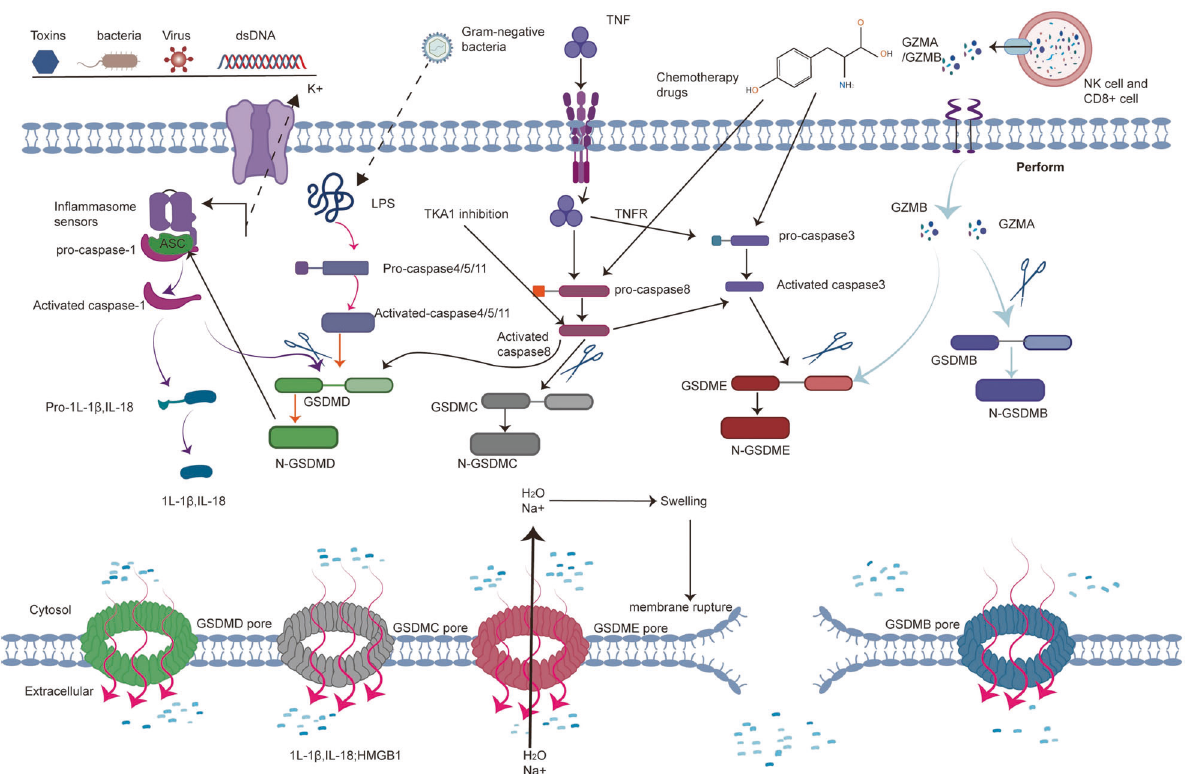
Fig. 1 Molecular mechanism of pyroptosis. The canonical in fl ammasome is assembled from intracellular sensor proteins in response to PAMPs and DAMPs. Active caspase-1 cleaves pro-IL-1 β and pro-IL-18 and results in the maturation of IL-1 β and IL-18 that are subsequently released from the N-GSDMD pore. Active caspase-1 also cleaves GSDMD, releasing N-GSDMD to form nonselective pores on the plasma membrane, which allows the release of mature IL-1 β and IL-18. In the noncanonical pathway, LPS directly binds to pro-caspase-4/5/11, resulting in activation of caspase-4/5/11, which cleaves GSDMD to trigger pyroptosis. In apoptotic caspase-induced pyroptosis, TNF activates caspase-8, which cleaves GSDMC and then induces pyroptosis in cancer cells. In addition, chemotherapeutic drugs trigger pyroptosis through the caspase-3/GSDME, caspase 1/GSDMD or caspase-8/GSDMC cascades. In the granzyme-A/B-dependent pyroptosis pathway, GzmA and GzmB from NK cells and CD8 + T cells enter cancer cells via perforin and recognise GSDMB and GSDME, respectively, to induce